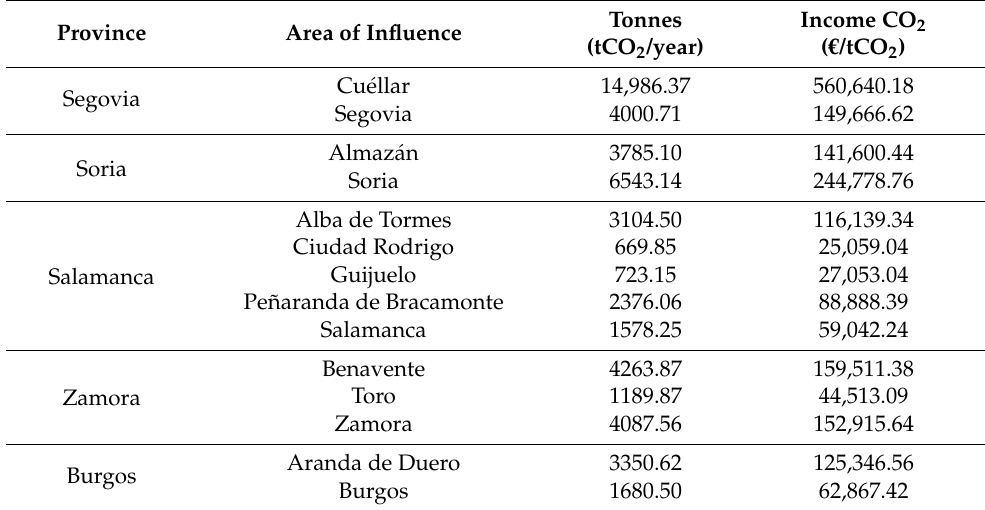
Table 3. Avoided CO 2 tonnes and expected